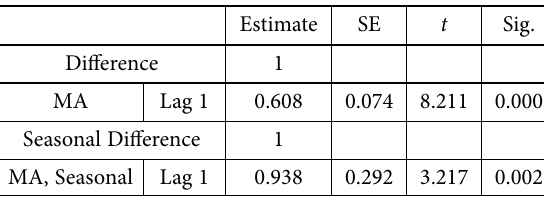
Table 4. The forecasted number of accidents on